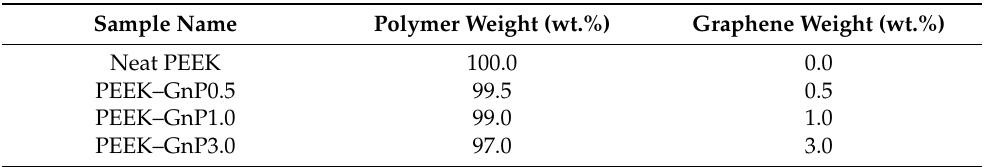
Table 1. Composition of PEEK–GnP